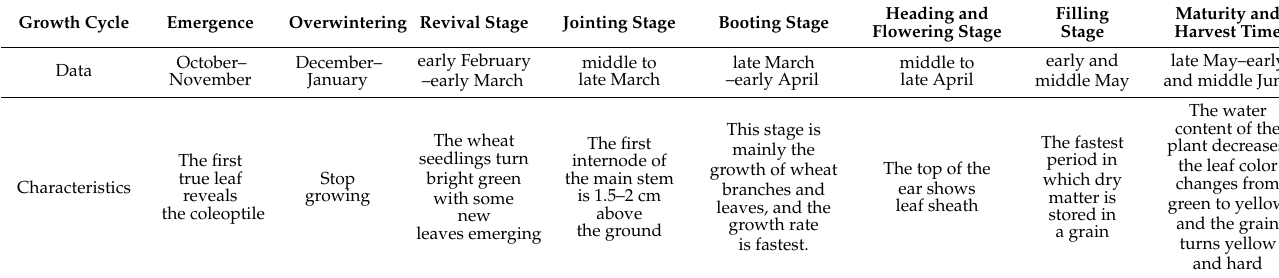
Table 1. Characteristics of winter wheat phenology in the study